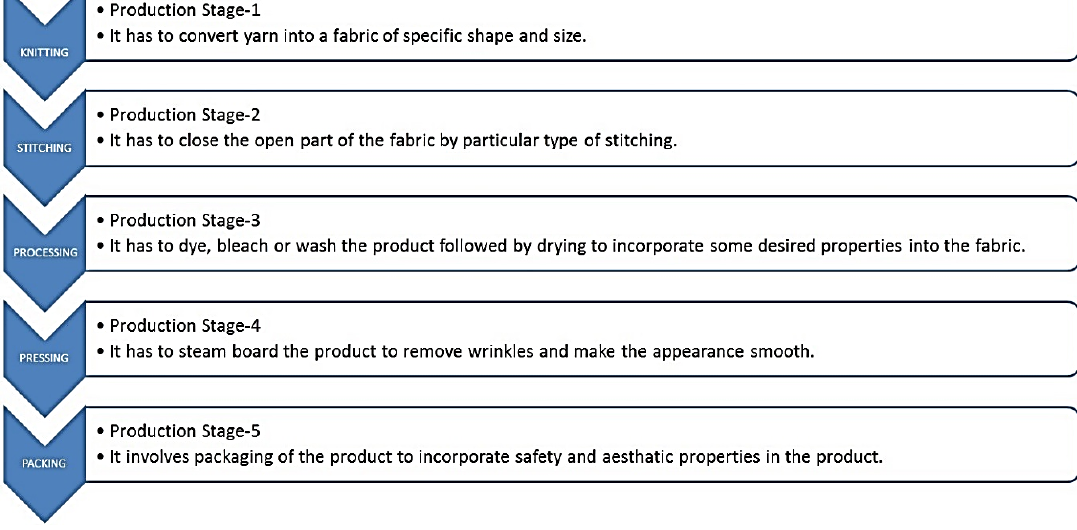
Figure 1. General production flow of an apparel manufacturing industry.